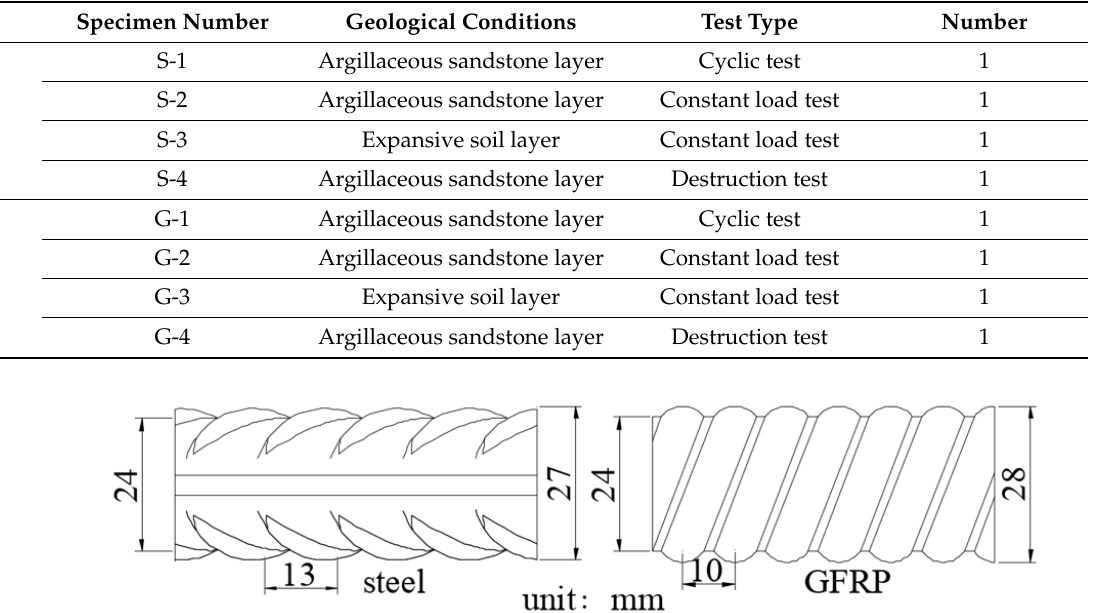
Figure 3. Surface properties of the steel and GFRP bar